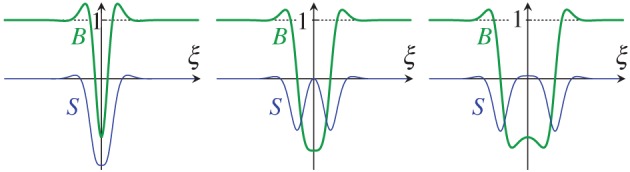
Examples of ‘preferred’ deformation modes, which are solutions of (B 20). Of the modes shown, the middle one has the lowest elastic energy.